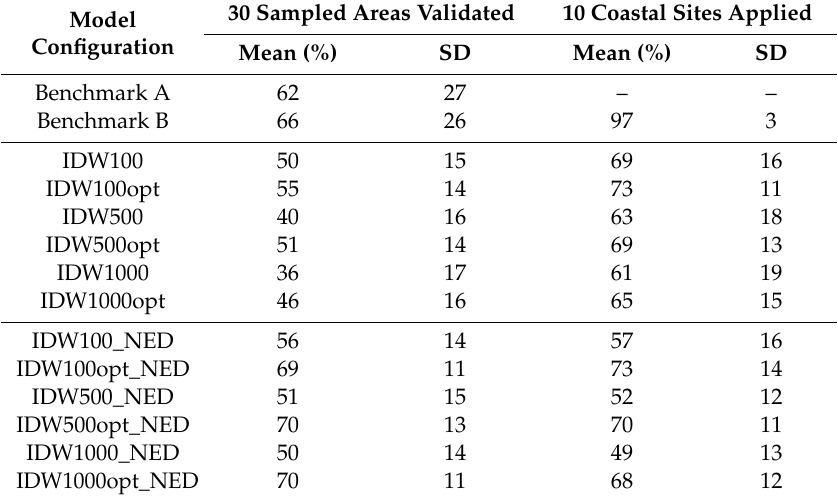
Table 2. Mean and SD of % Fit in 30 sampled validation sites and 10 selected coastal sites. 30 Sampled Areas Validated 10 Coastal Sites Model Configuration